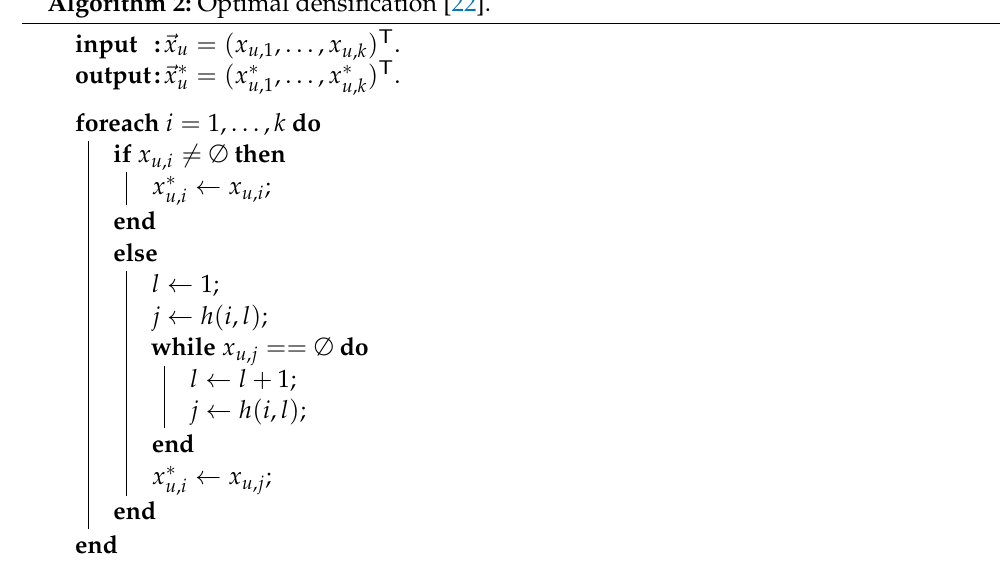
Algorithm 2: Optimal densification [22].